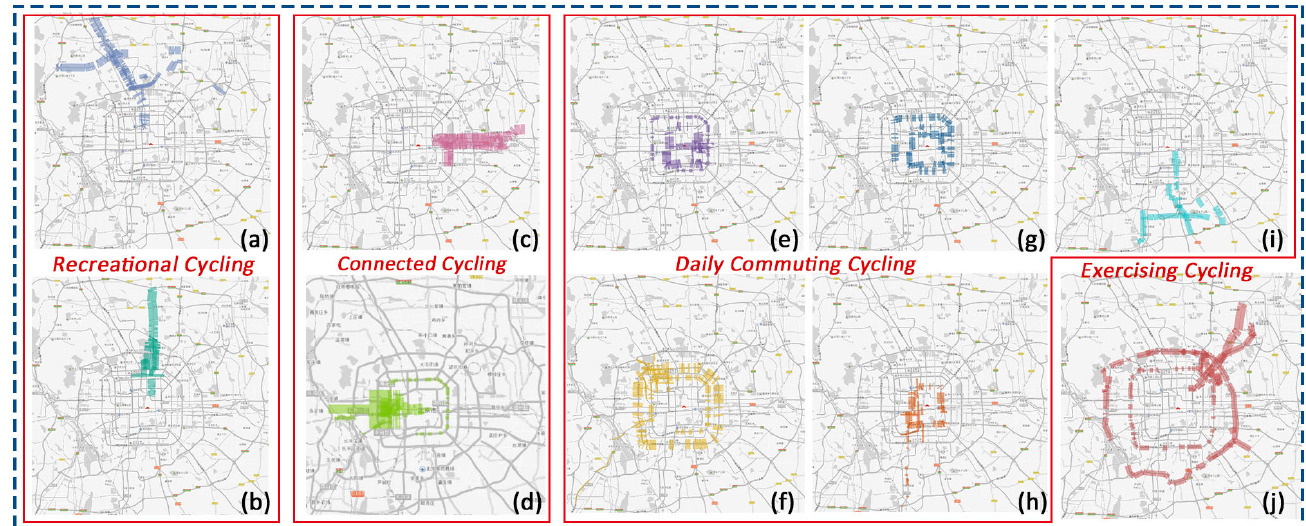
Figure 7. ( a , b ) Topics of recreational cycling distributed on the map. ( c , d ) Topics of connected cycling distributed on the map. ( e – i ) Topics of daily commuting cycling distributed on the map. ( j ) Topic of exercising cycling distributed on the